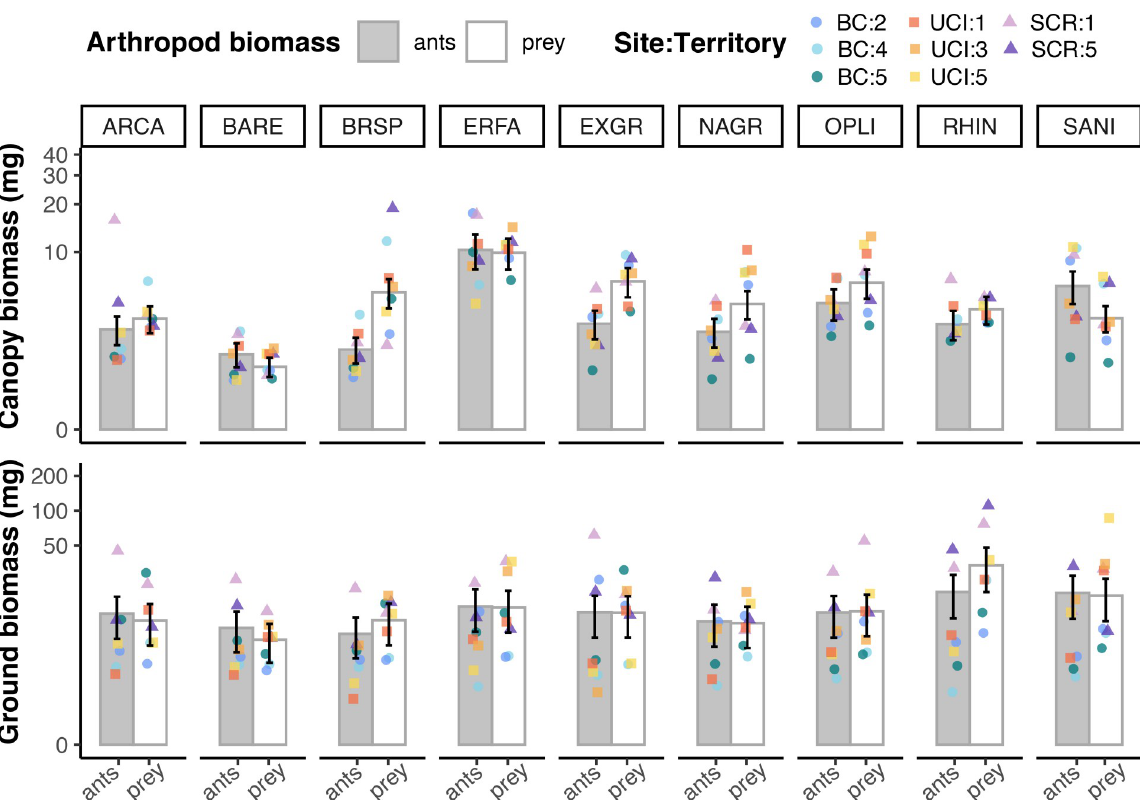
Fig 3. Territory- and habitat-element-specific estimates of arthropod density among habitat elements from canopy sampling (top row) and ground pitfall traps (bottom row). Grey bars show the biomass of non-native arthropods, Isopoda and Hymenoptera. White bars show the biomass of arthropod orders included in diet samples. Points are shown for each bird nesting territory, with shape referencing the study site and each territory a different color. Arthropods were sampled from native plant species; Artemisia californica (ARCA), Erioginum . fasciculatum (ERFA), O . littoralis (OPLI), Rhus integrifolia (RHIN), Sambucus nigra (SANI), and grasses (NAGR).; non-native Brassica nigra (BRSP) and grasses (EXGR); and bare ground (BARE). Bare ground was sampled by both pitfall sampling and vacuum collecting any arthropod observed within 0.5 m of the pitfall trap, referred to as canopy sampling above for consistency with plant sampling. (6.8% ± 0.94 SE) or contained artificial elements (8.6% ± 3.9 SE) (e.g., golf range, landscaping,